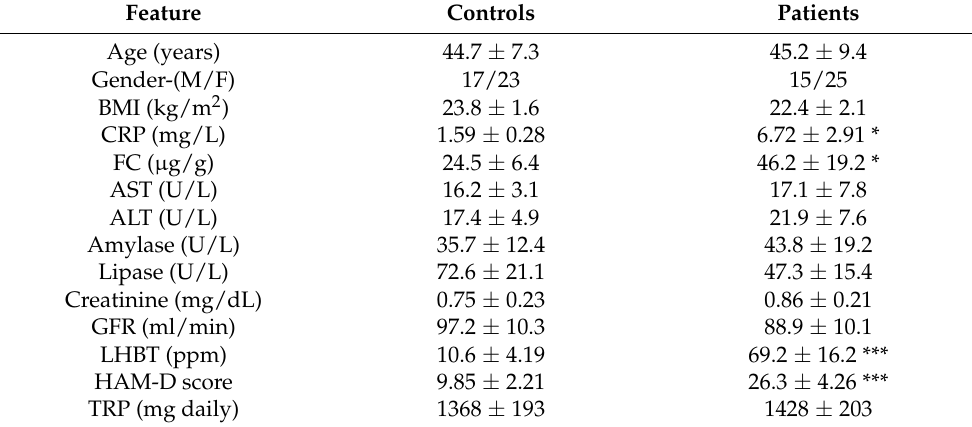
Table 1. Characteristics of healthy subjects (Controls, n = 40) and patients with irritable bowel syndrome (SIBO, n = 40) included in the study, laboratory data, mental state, and tryptophan intake.